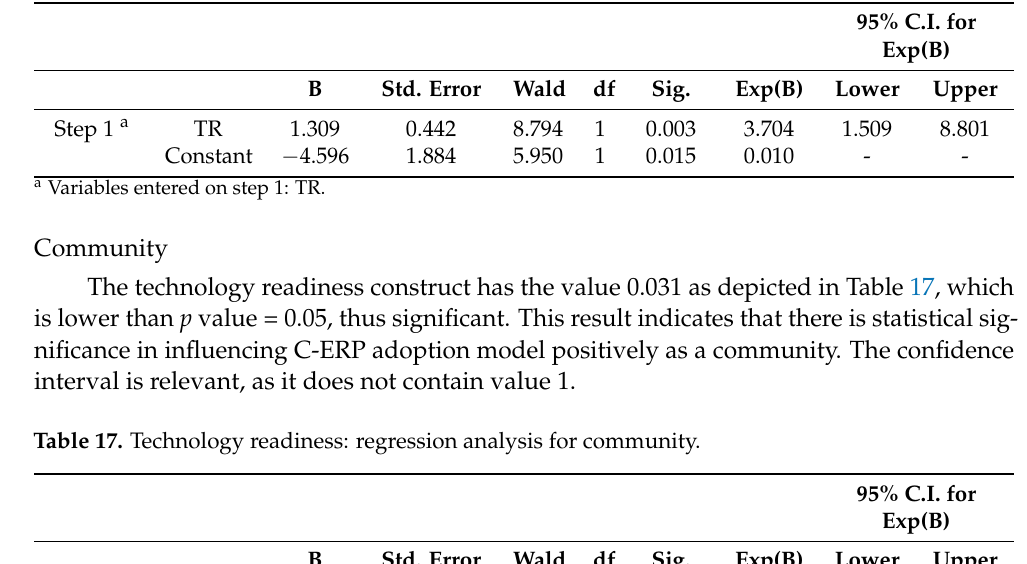
Table 16. Technology readiness: regression analysis for IaaS.